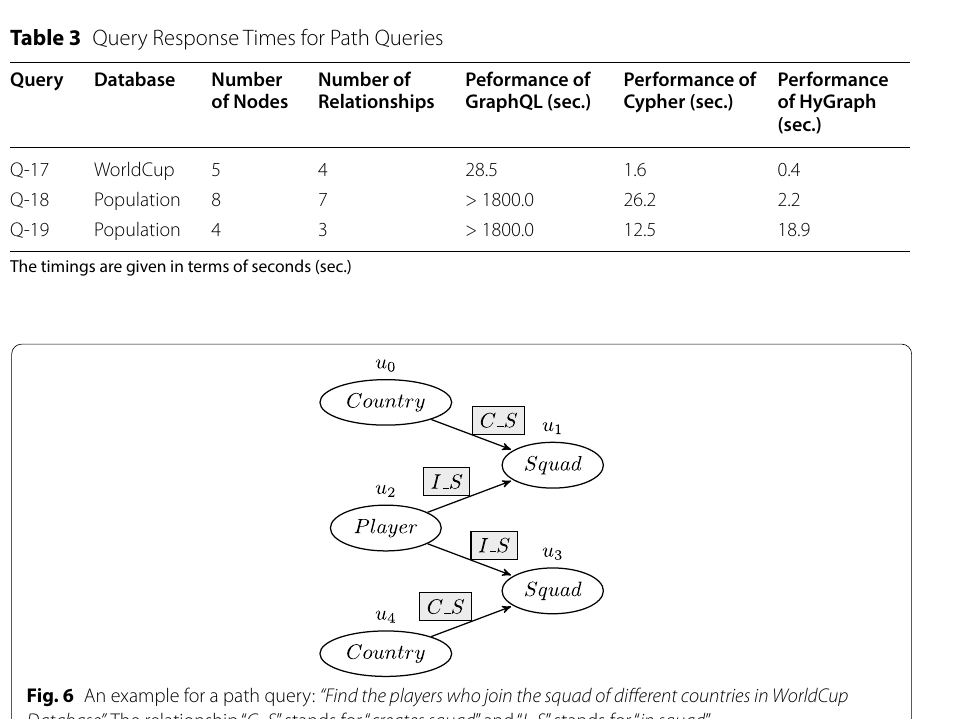
Table 3 Query Response Times for Path Queries